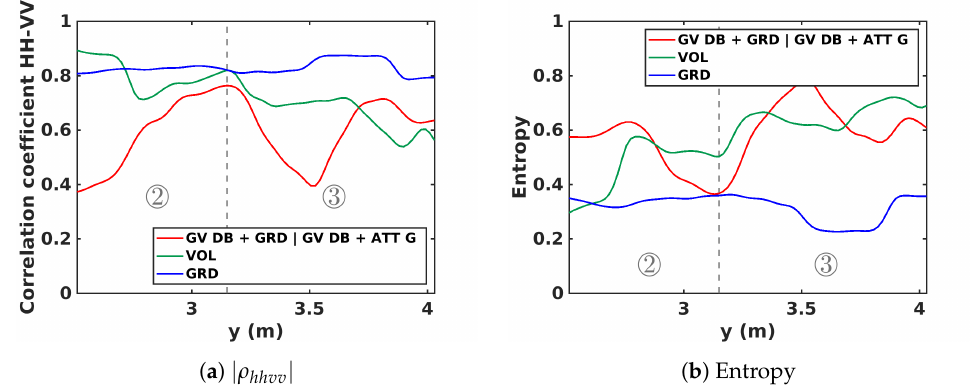
Figure 18. Polarimetric features between bare ground, ground, and GV DB mixed and volume.